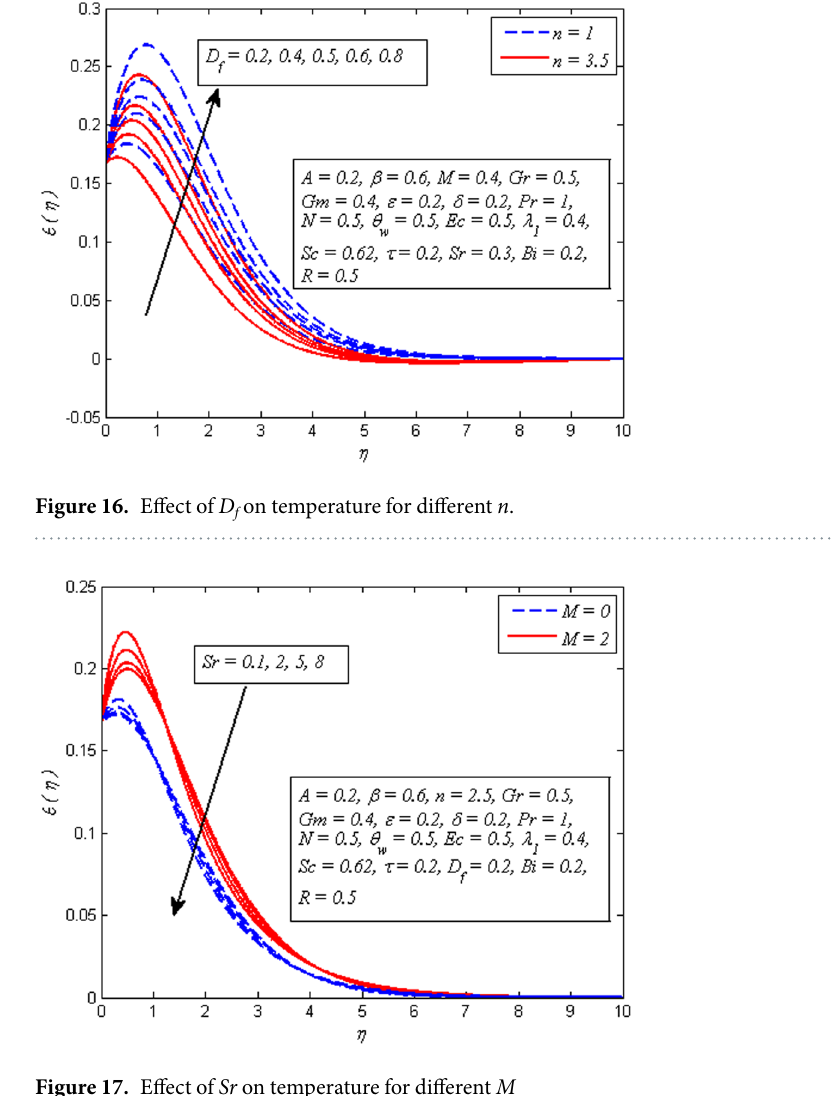
Figure 17. Effect of Sr on temperature for different